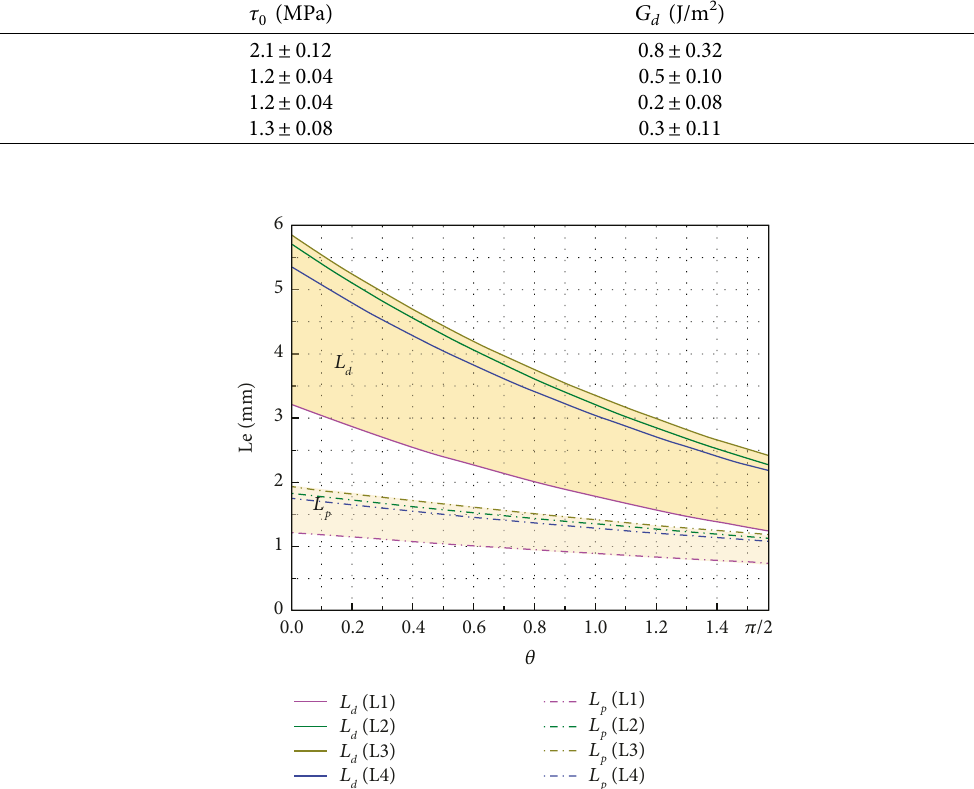
Figure 18: Critical embedment length